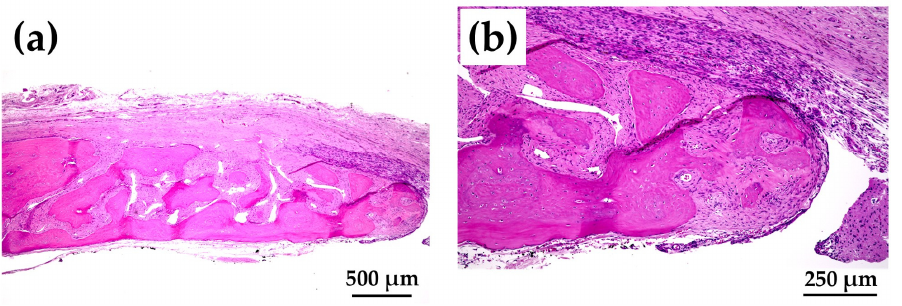
fication). ( b ) Further magnified HE-stained image of the bone edge in Figure 12a (10× magnifica- tion).